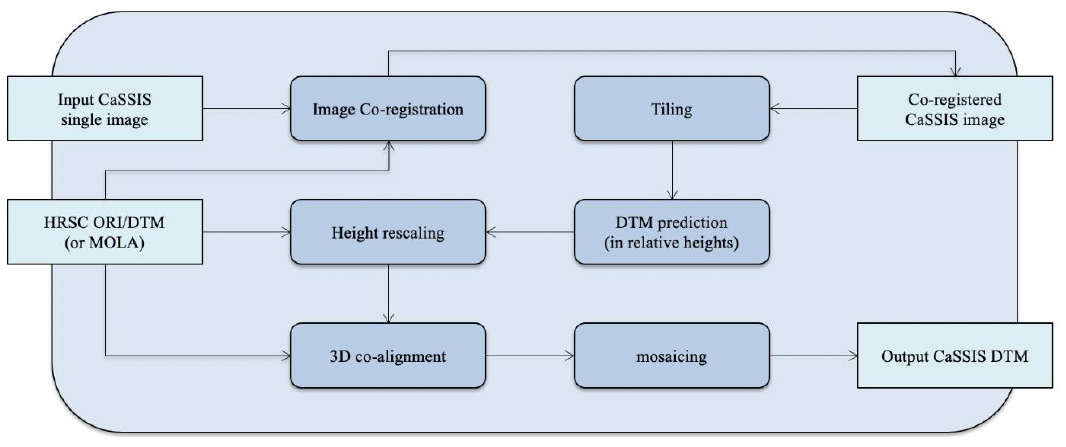
Figure 4. Flow diagram of the MADNet single-image CaSSIS DTM processing